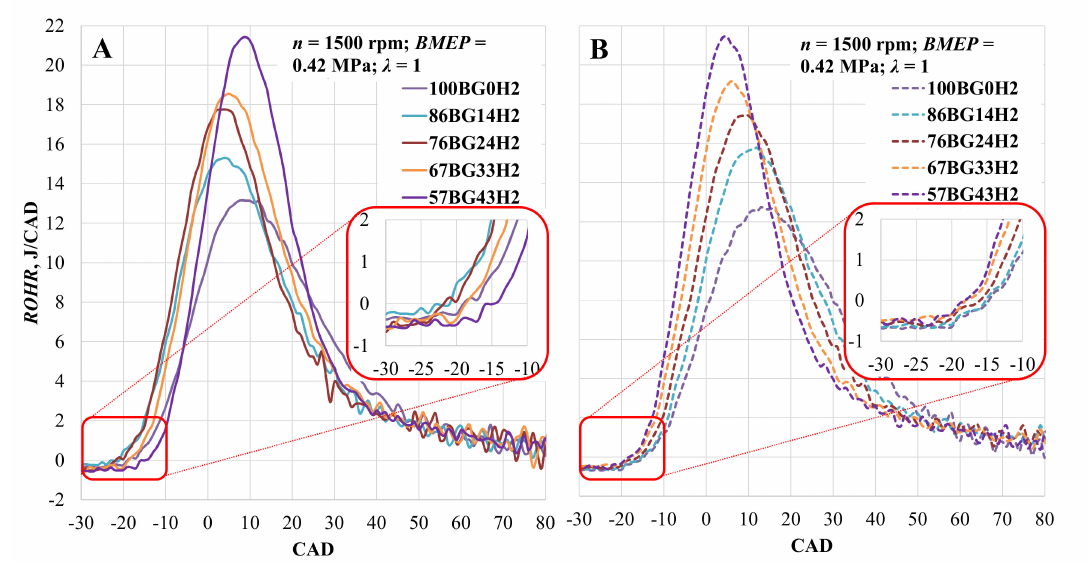
Figure 7. Rate of heat release (ROHR) in the cylinder depending on hydrogen concentration. ( A )—with optimal ST for the mixture; ( B )—with optimal CNG ST.